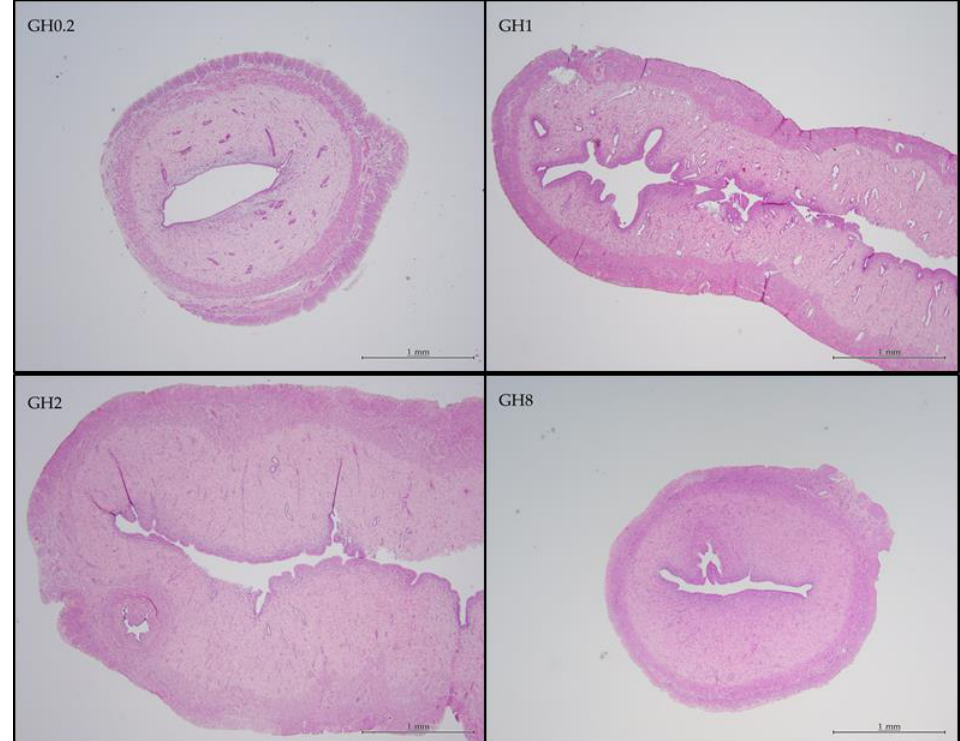
Figure 9. Comparison of the uterine lumen architecture following GH administration in virgin female Sprague–Dawley rats. Uterine tissues were stained with an H&E stain. All measurement bars are 1 mm. GH0.2 (0.2 g GH/kg bw/day); GH1 (1 g GH/kg bw/day); GH2 (2 g GH/kg bw/day); GH8 (8 g GH/kg bw/day); bw: body weight.